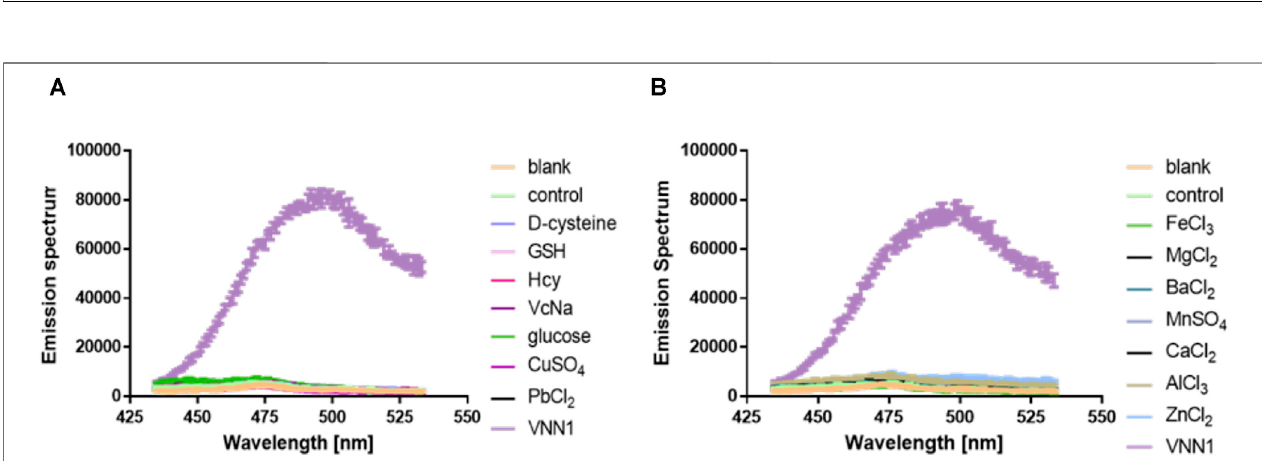
FIGURE 4 | Probe in vitro selectivity experiment. (A) Emission spectrum of probe PA-AFC and the following substance: Reduced glutathione (1 mM), D-cysteine (1 mM), glucose (1 mM), vitamin C sodium salt (1 mM), Homocysteine (1 mM) (1 mM), inorganic salts (1 mM) and VNN1 enzyme (15 ng/ml); (B) Emission spectrum of probe PA-AFC and various inorganic salts (1 mM), VNN1 enzyme concentration is 15 ng/ml.